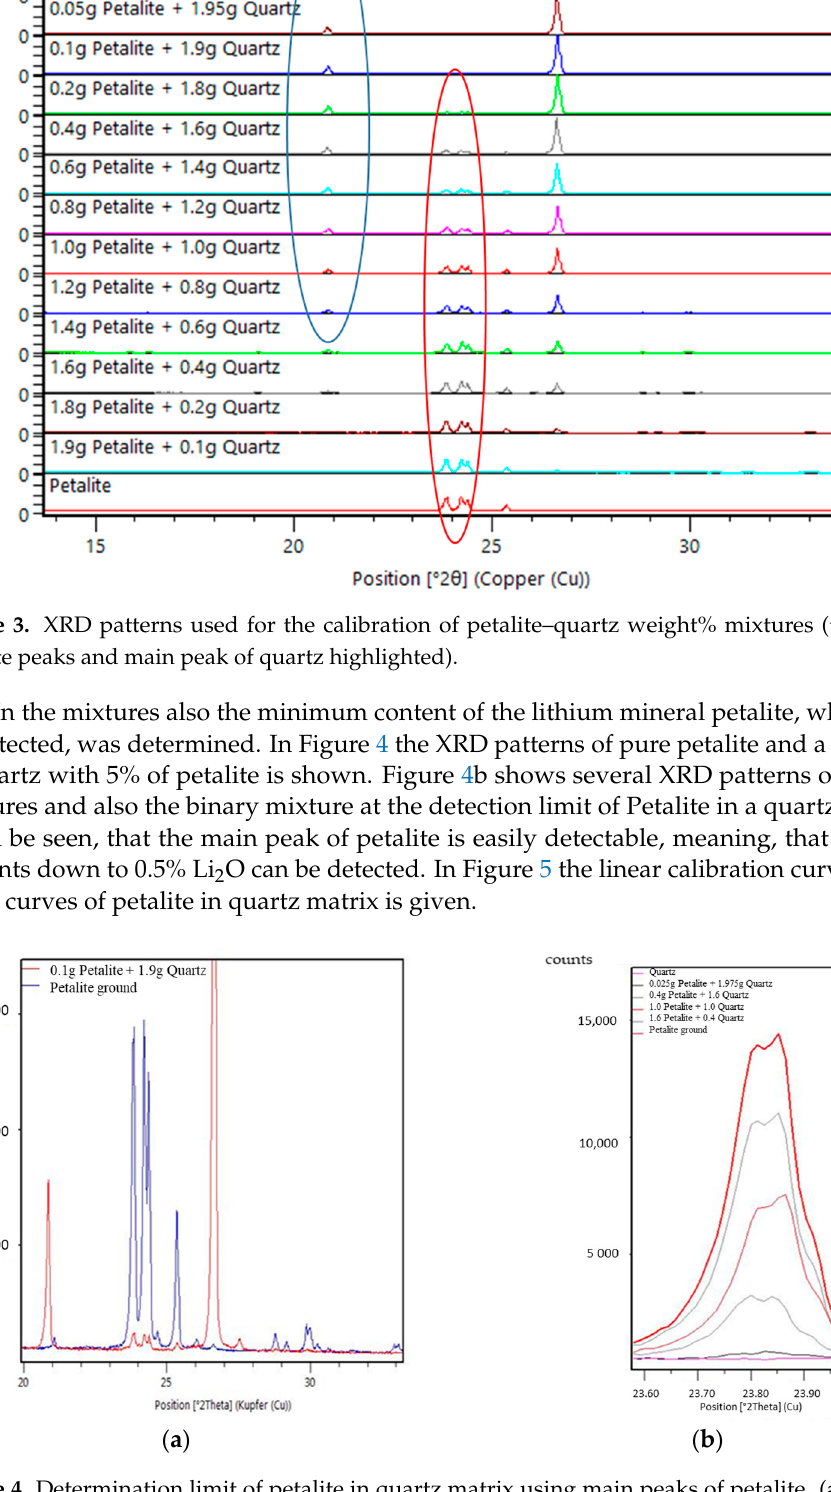
Figure 5. PLSR calibration curve for petalite–quartz mixtures. From these different contents of petalite in lithium mineral quartz matrix the detec- tion limit for lithium oxide can be derived (Table 3) showing the contents of lithium oxide derived from XRD patterns in Figure 4b. The PLSR calibration curve for petalite–quartz mixtures is given in Figure 5.